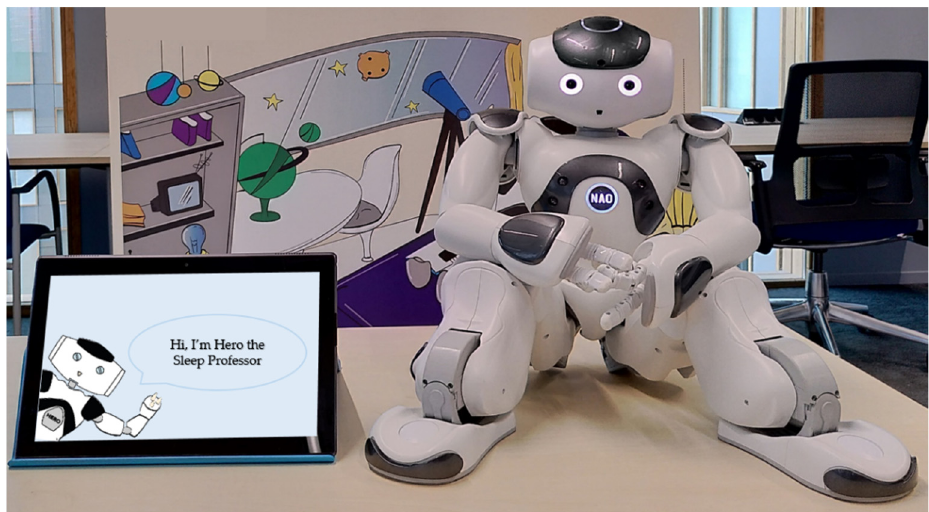
Figure 1. Picture of the robot and set-up.